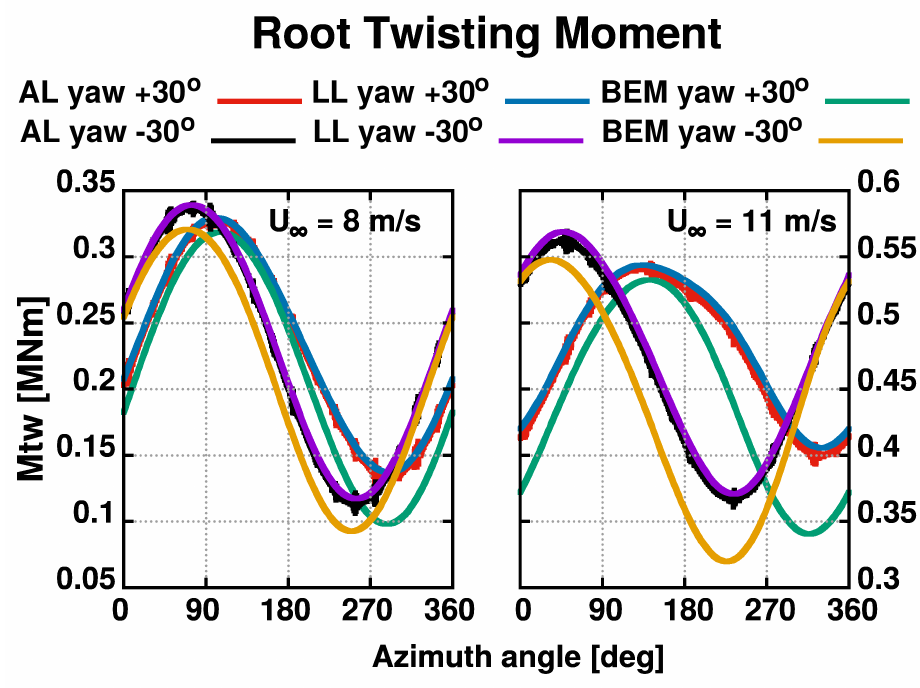
Figure 28. Twisting moment of blade root at 30 ◦ yawed wind speed at 8 and 11 m/s.